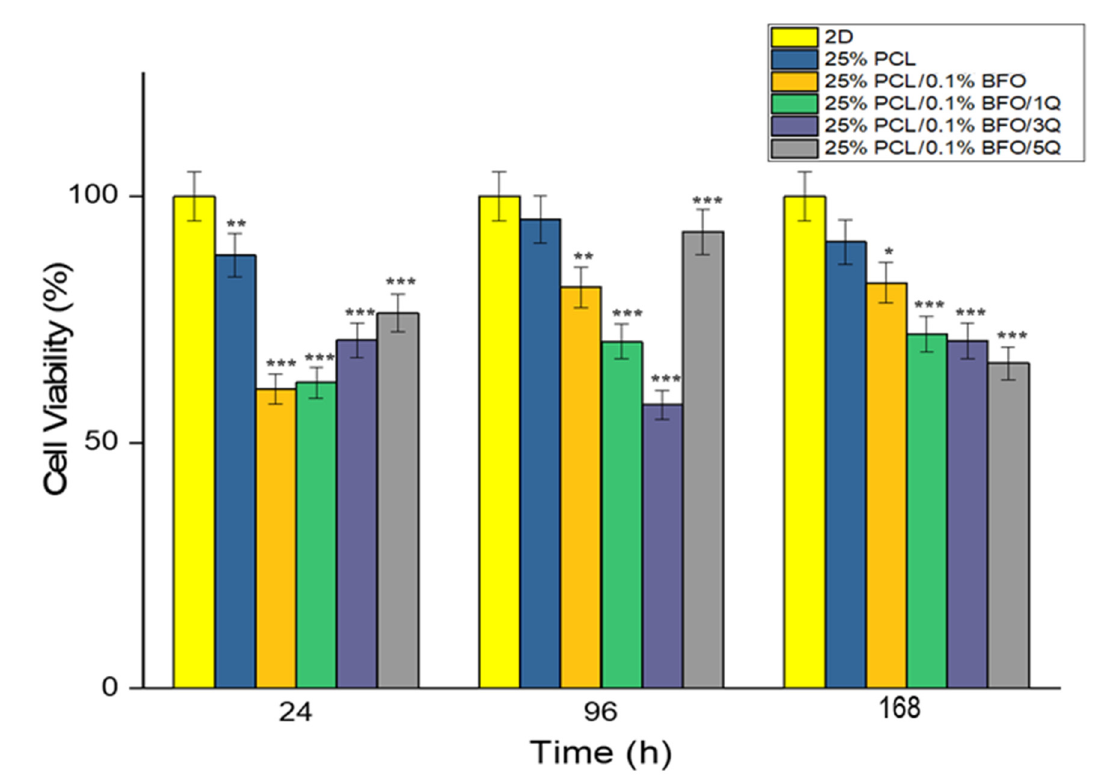
Figure 11. MSC viability of 6 microfibrous scaffolds at 24, 96 and 168 h. Statistical significance was determined using one-way ANOVA Tukey-Kramer multiple comparisons test, with comparison to 2D. * p < 0.05, ** p < 0.01, and *** p < 0.001 indicate significance levels.